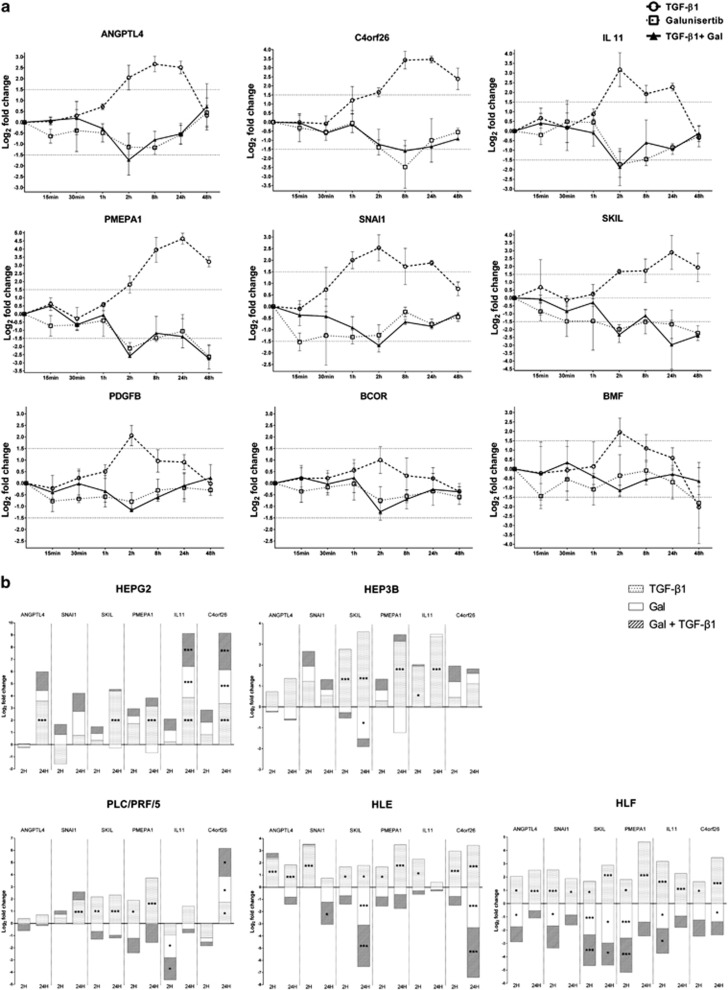
Relative quantitation of mRNA levels of target genes at different time resolutions in HLE, HLF, HepG2, Hep3B PLC/PRF/5 cells. Three replicates were performed for each cell lines. (a) Different mRNA levels of target genes in HLF cell line from 15 min to 48 h. For each gene, the change of expression level (−ΔΔCt) for qRT-PCR is calculated by – (delta Ct target–delta Ct control) and the data were shown as mean with S.D. There was no significant change for all the targets within 2 h. Different targets showed different response times to TGF-β1 and galunisertib (gal). Some of them even had a significant response after 48 h. (b) The mRNA levels of target genes in comparison with the expression levels in control samples in five cell lines after treated for 2 and 24 h. For each gene, the change of expression level (−ΔΔCt) for qRT-PCR is calculated by – (delta Ct target–delta Ct control). Selected targets show a response to TGF-β1 and galunisertib both in early TGF-β signature and late TGF-β signature cell lines. Log2 fold change <−1.5 or >1.5 and P-value <0.05 (*P<0.05; **P<0.005; ***P<0.0001) were considered significant